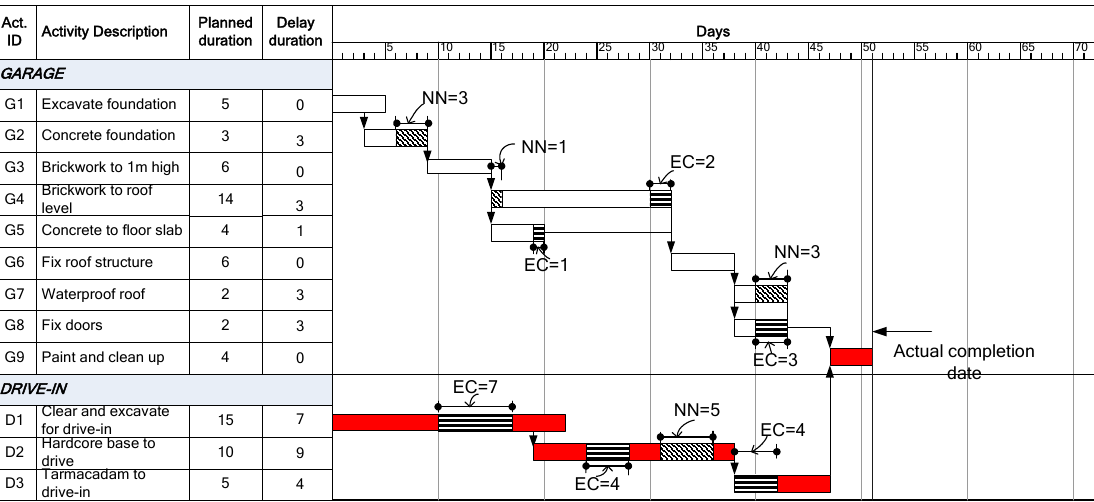
Figure 4. As-built schedule with